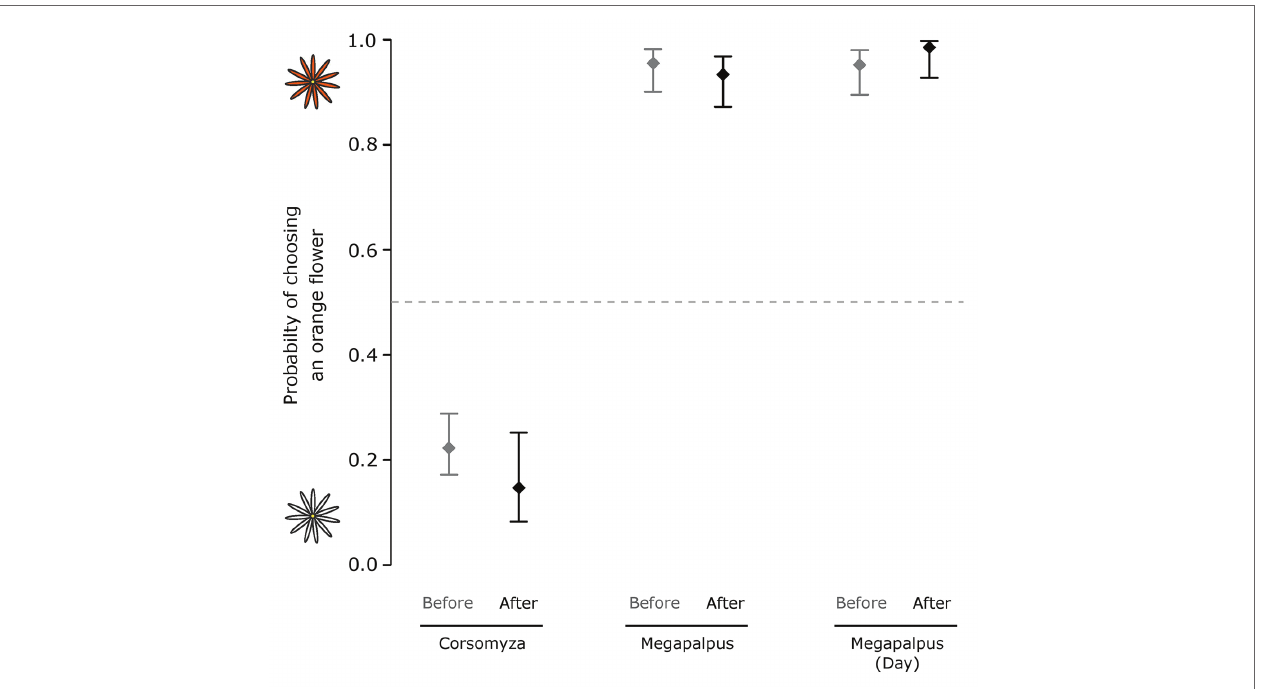
FIGURE 7 | The effect of color conditioning on the flower color choices of two dominant fly pollinator species. Choice experiments were used to characterize flower color choices before and after conditioning. In the first experiment Corsomyza nigripes and Megapalpus capensis flies were conditioned on flowers of their non-preferred color for 1 h, and in a second experiment, Megapalpus capensis flies were forced to feed on non-preferred white flowers for a day. Flower color preferences were not altered by